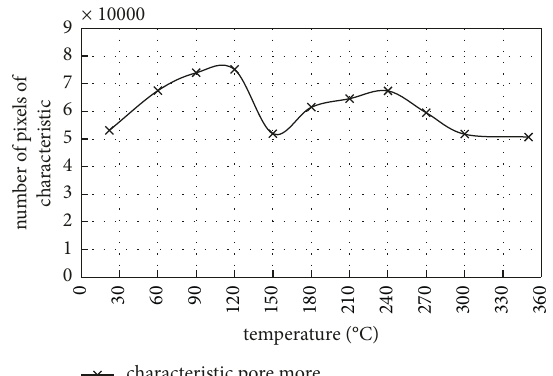
Figure 6: The graph for the identification of pore pixels number of the coking coal sample with the increasing